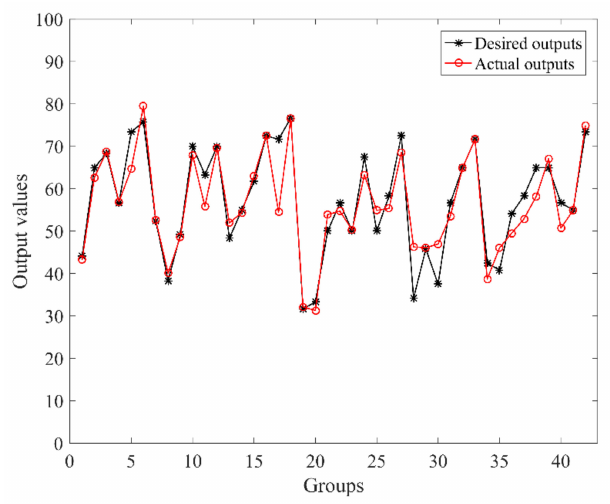
Figure 7. Comparison between desired outputs and actual outputs ( β = 0.75, RMSE = 4.85). 2. n = 5